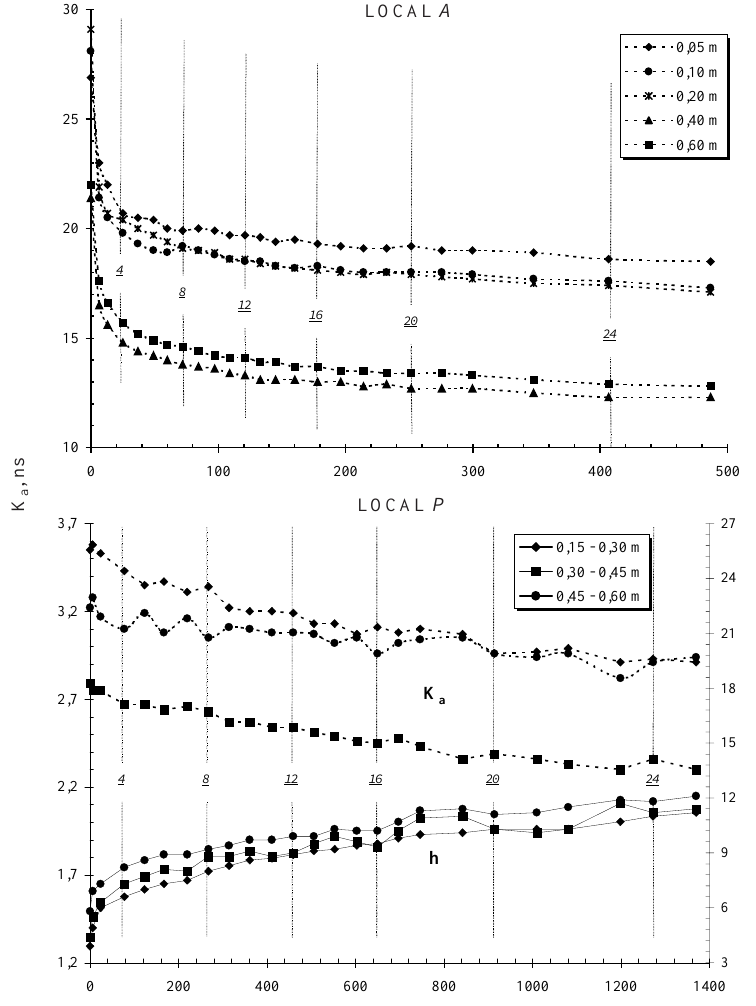
Figura 1. Leituras do TDR ( Ka , ns) e dos tensiômetros ( h , cm-Hg) ao longo do tempo (h) nas profundidades de observação nos locais A e P . (os números sublinhados no gráfico referem-se ao número seqüencial da